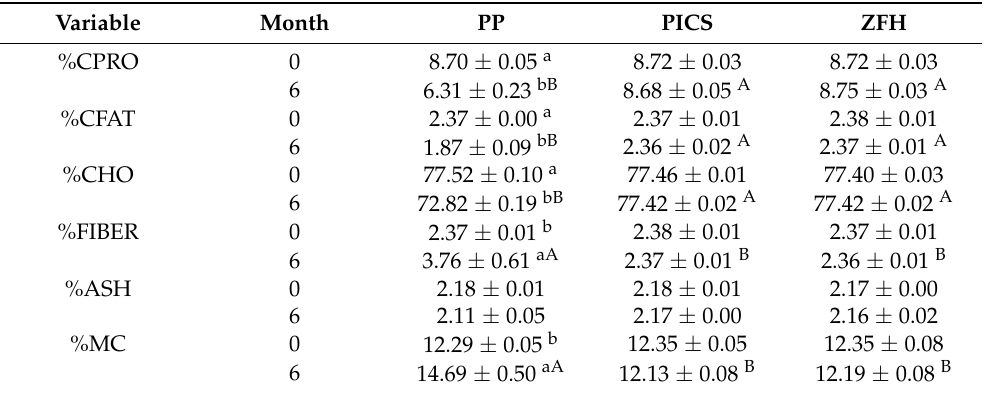
Table 7. Mean ( ± SE) percentage of crude protein (%CPRO), percentage of crude fat (%CFAT), percentage of carbohydrate (%CHO), percentage of crude fiber (%CFIBER), percentage of ash content (%ASH), and percentage of moisture content (%MC) of maize from Polypropylene (PP), Purdue Improved Crop Storage (PICS), and ZeroFly ® Hermetic (ZFH) bags sampled during the months